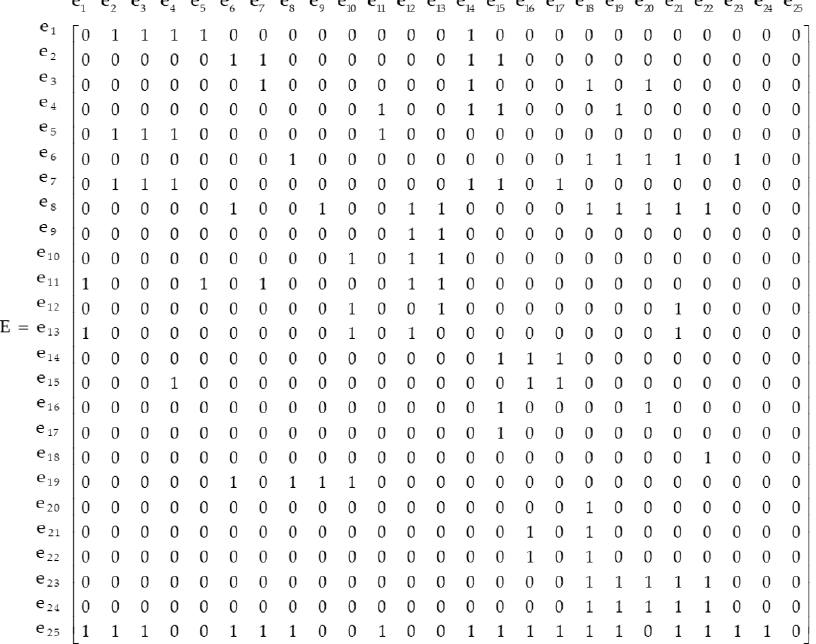
Figure 3. Community emergency management index pyramid network analysis structure chart.